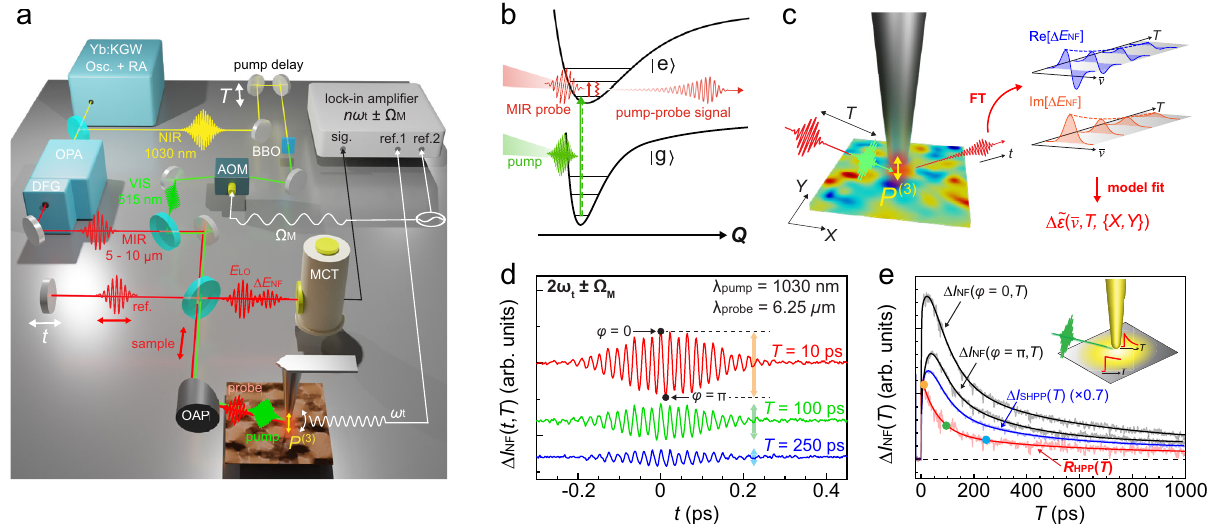
Fig. 1 Heterodyne pump-probe nanoimaging. a HPP IR s -SNOM, with the ~ 185 fs optical 1.2/2.4 eV (1030/515 nm) pump excitation, ~170 fs tunable mid- IR 0.12 – 0.25 eV (5 – 10 μ m) probe, and interferometric heterodyne near- fi eld detection. AOM acousto-optic modulator, DFG difference-frequency generation, OAP off-axis parabolic mirror, OPA optical parametric ampli fi er, Osc . + RA oscillator and regenerative ampli fi er laser system. b Far-from- equilibrium excitation followed by mid-infrared probe of the transient low-energy vibrational and electronic response coupled to the excited state. c The tip-localized time domain signal of Δ E NF ð ν Þ , from which the pump-induced change in the nano-localized complex dielectric function Δ ~ ϵ NF ð ν Þ is retrieved with spatiotemporal-spectral resolution. d Sideband-demodulated pump-probe interferogram Δ I NF ( t , T ) for a Ge reference sample. e T -dependent pump- probe transients from two different E LO phase values Δ I NF ( ϕ = 0, T ) and Δ I NF ( ϕ = π , T ), the derived frequency-averaged heterodyne pump-probe amplitude relaxation R HPP ( T ), and the self-homodyne pump-probe signal relaxation Δ I SHPP ( T ). Inset: tip-enhanced pump excitation in nano-localized probe volume, leading to faster relaxation from higher excited carrier Δ I HPP ( t , T ) is then Fourier transformed with respect to t and